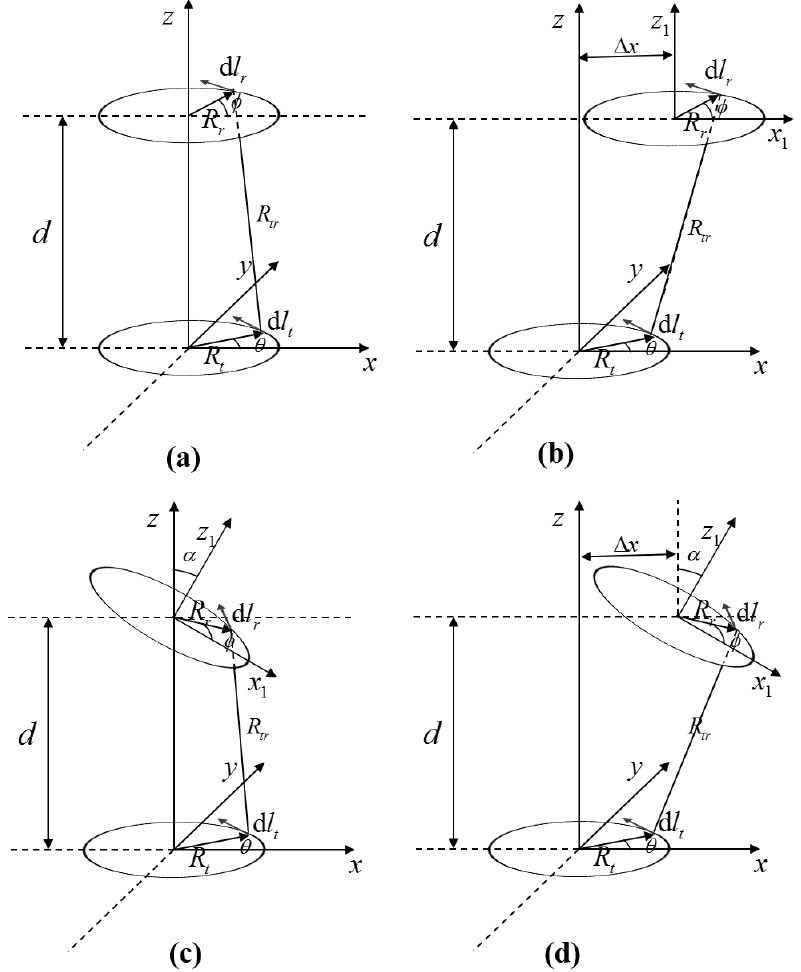
Figure 3. Schematic diagram of coil relative position: ( a ) no misalignment, ( b ) only lateral misalignment, ( c ) only angular o ff set, ( d ) a general case including both angular and lateral o ff